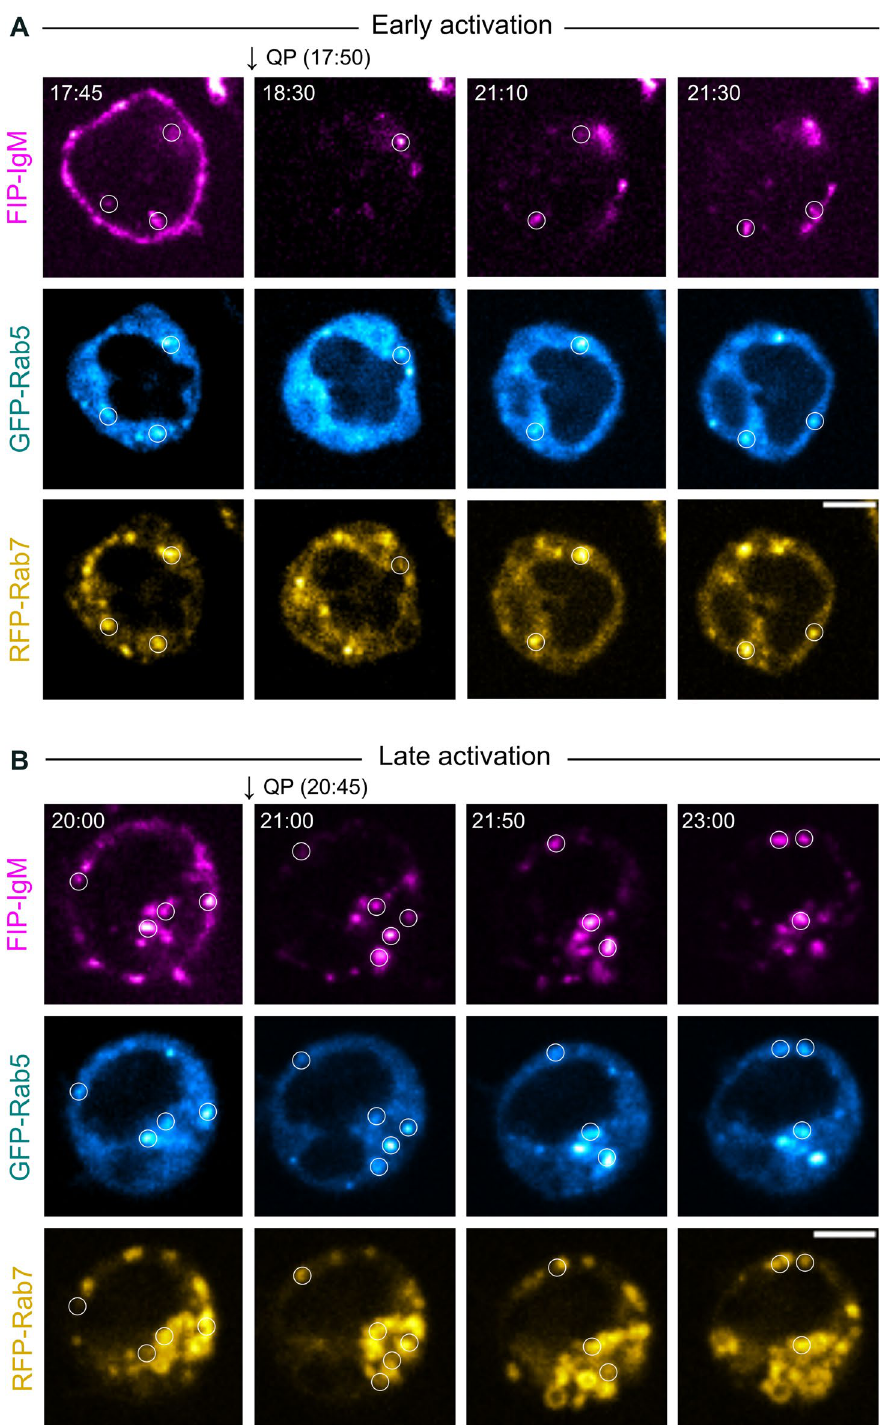
Figure 4. Internalised antigen colocalizes with endosomal markers in live imaging. ( A , B ) B cells were transfected with GFP-Rab5 and RFP-Rab7 and engaged with ATTO-FIP-IgM on ice. Cells were transferred to 37 °C to trigger endocytosis and the recording was started. QP was added to the cells at indicated time points (arrows) after activation without interrupting image acquisition. Images show an early ( A ) or late stage ( B ) of antigen traffic. Images were acquired using a SDCM (one slice, one frame every 5 s). Time in minutes after triggering endocytosis is indicated in the top-left corner. Scale bar: 5 µm. LUTs: Hot Magenta, Hot Cyan and Hot